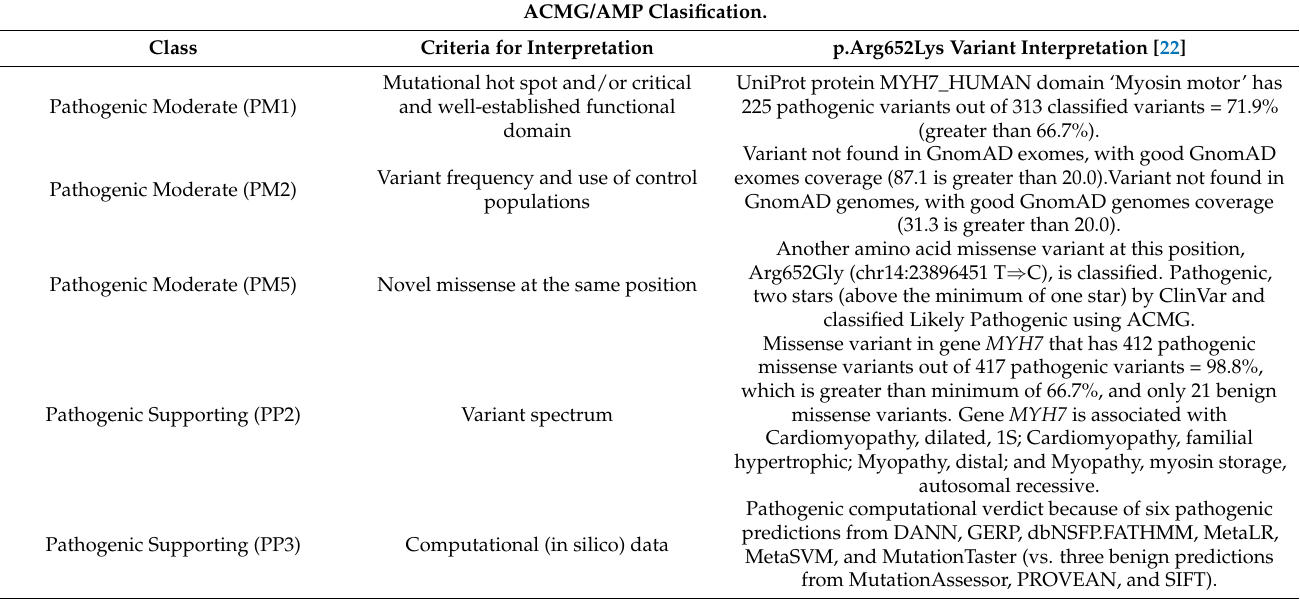
Table 4. Evidence framework for the pathogenicity classification of the p.Arg652Lys variant according to the criteria of the American College of Medical Genetics and Genomics (ACMG) and the Association for Molecular Pathology (AMP). In this diagram, the criteria are organised according to the type of evidence, as well as their